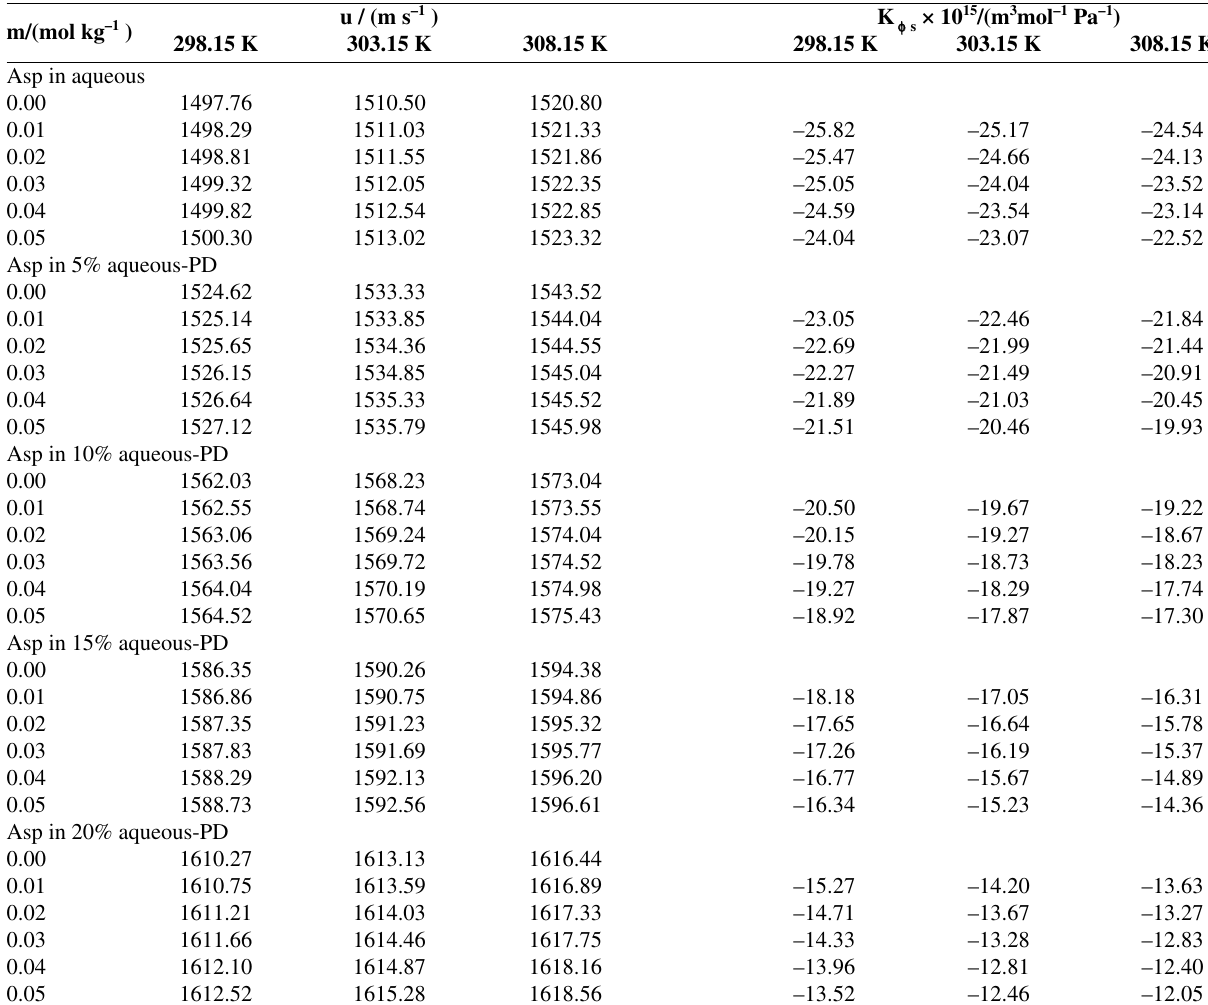
Table 4. Speeds of sound, u, and apparent molar isentropic compressibilities, K φ 20%, PD w/w in water) as function of molality, m, of Asp at different temperatures. m/(mol kg –1